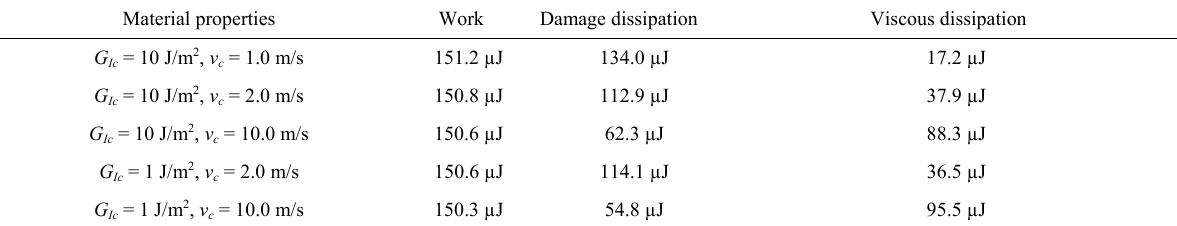
Table 3: Work and dissipations at end of simulation for three unit elements model with crack